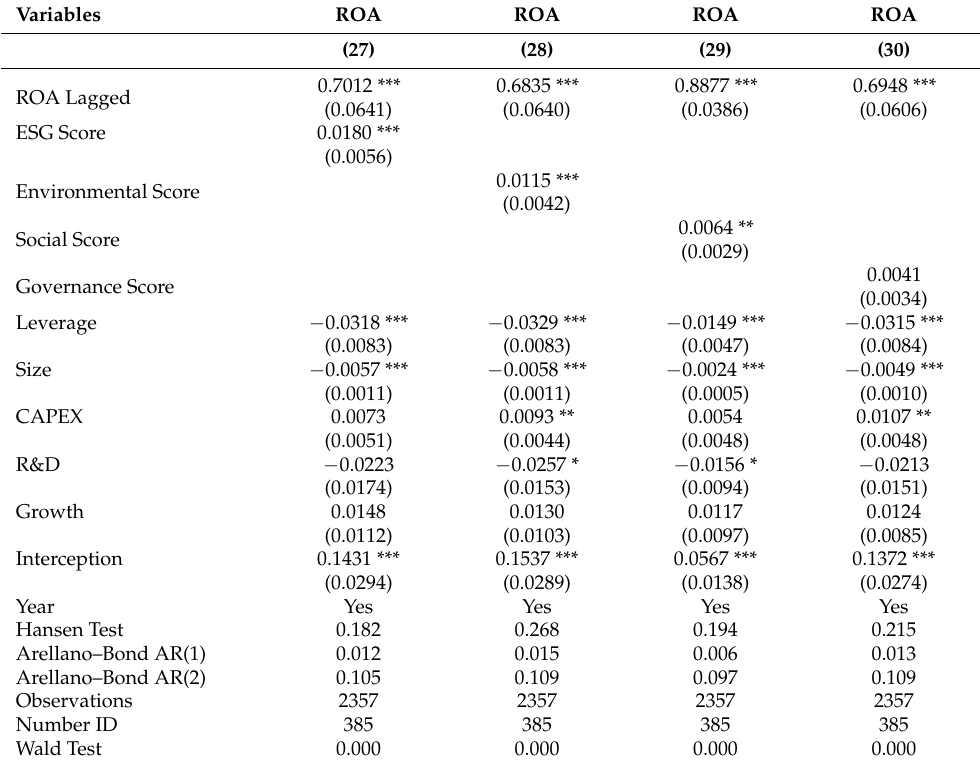
Table 8. Two-step system GMM regression for